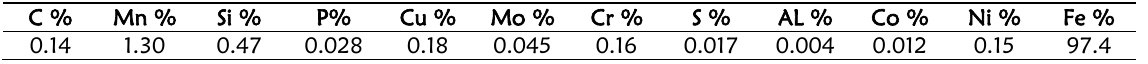
Table 1: Chemical composition of carbon steel (measured).